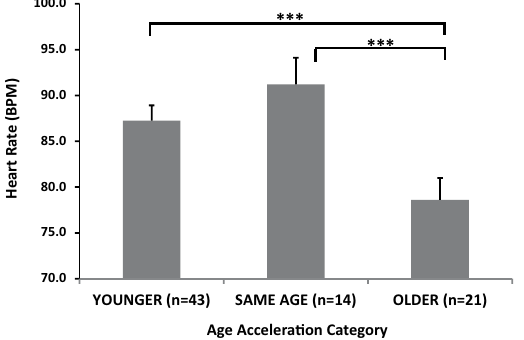
Figure 3. Heart rate during the dark phase of the dark-enhanced startle test across age acceleration groups. ANOVA showed a main effect of age acceleration category on HR, F(2,77) = 6.59, p = 0.002. Post-hoc tests showed that the older groups had significantly lower HR than the other two groups. *** p < 0.01. Abbreviations: HR, Heart